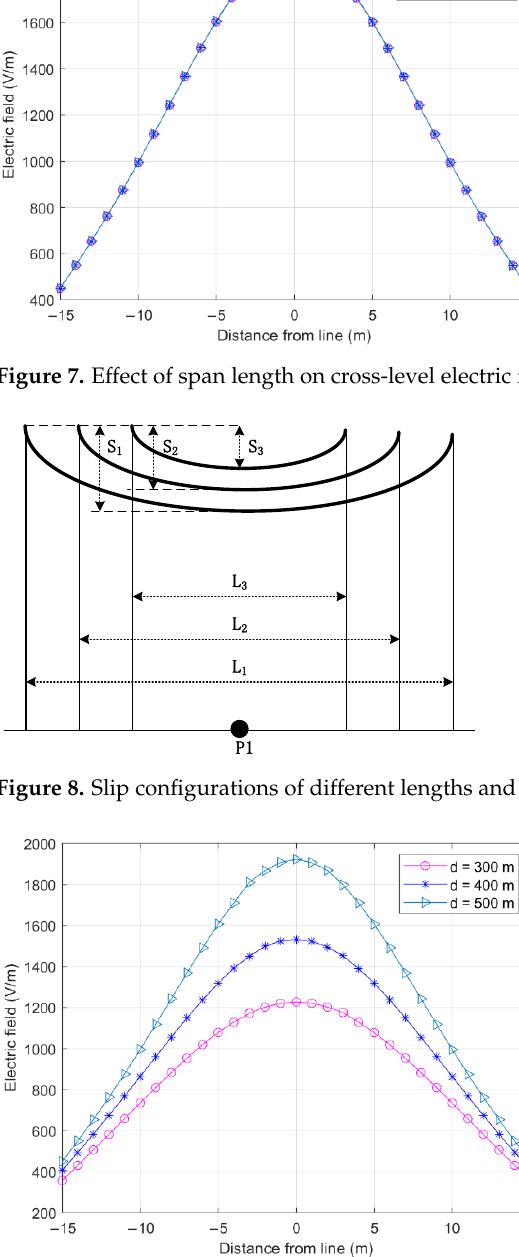
Figure 9. Effect of span length on cross-level electric field ( S 1 > S 2 > S 3 ).